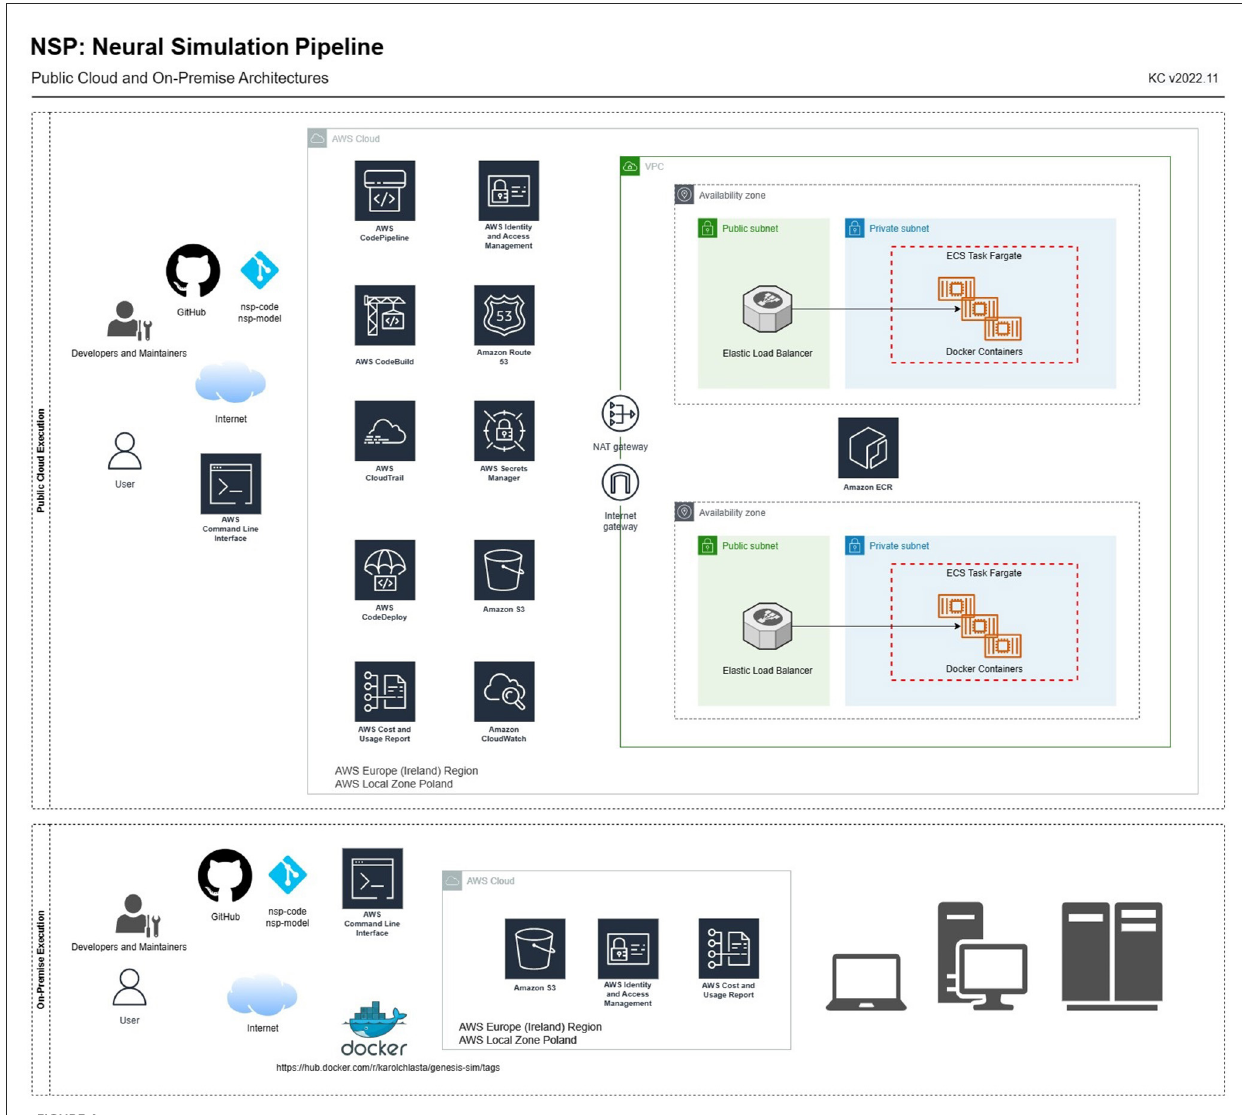
FIGURE4 NSP architecture for a full public cloud (AWS) simulation execution (top) and an on-premise execution (bottom) . The diagram presents both AWS services and network components needed to set up a VPC required to execute simulations in-cloud through Amazon Elastic Container Registry and Amazon Elastic Container Cluster running on AWS Fargate, a serverless, pay-as-you-go compute